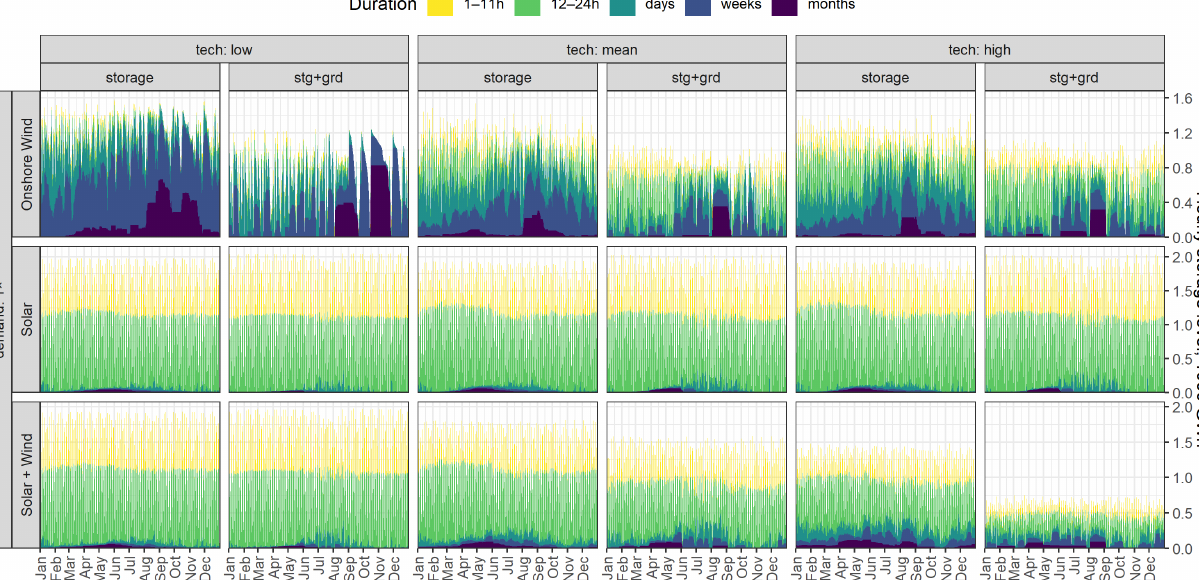
Figure A10. Estimated solar power supply curve with potential cumulative capacity by cluster, assuming 1% use of territory of each cluster.